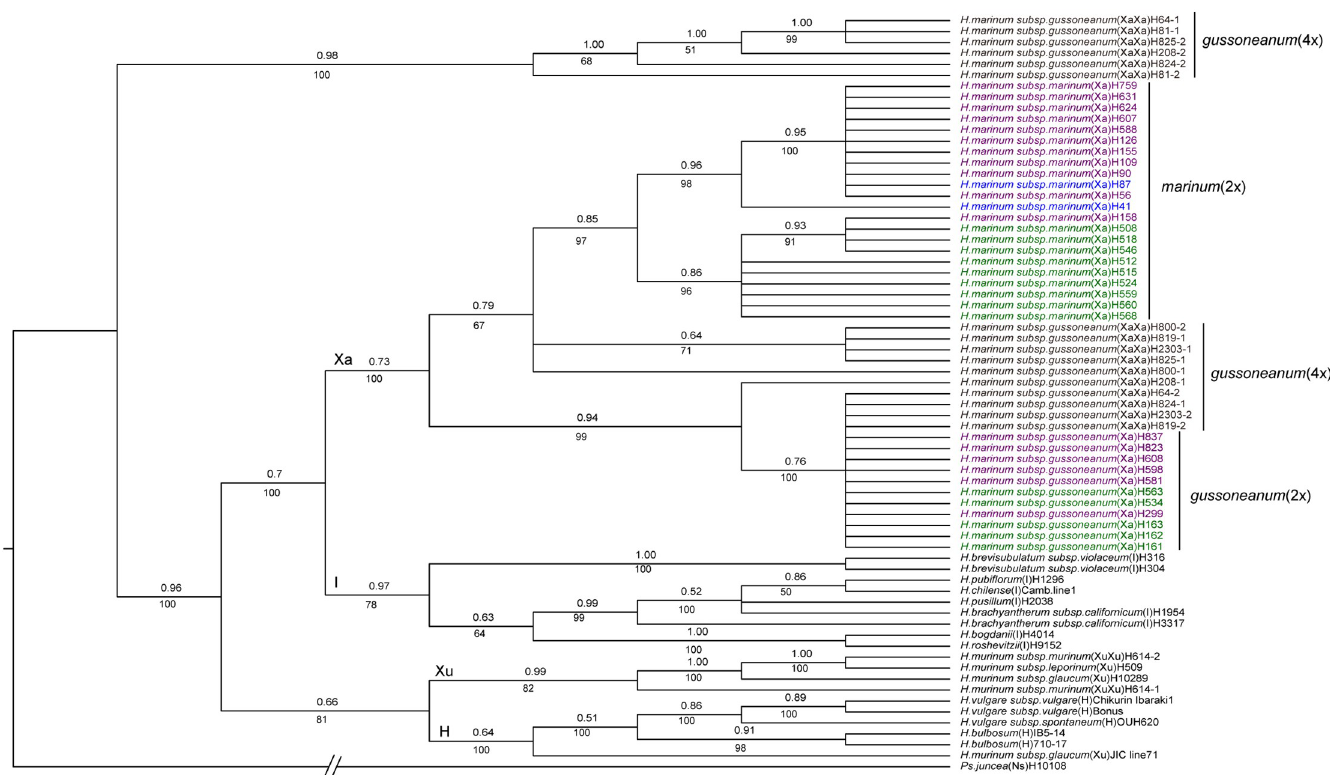
Fig 1. Strict consensus trees derived from TRX sequence data was conducted using the HKY+G model by Bayesian analysis. The main topologies generated by Maximum parsimony analysis are similar. Numbers above and below branches are Bayesian posterior probability (PP) values and bootstrap values, respectively. Psathyrostachys juncea was used as the outgroup. Consistency index (CI) = 0.775, retention index (RI) = 0.894. Geographic distribution of species: western Mediterranean (green), central Mediterranean (purple), eastern Mediterranean